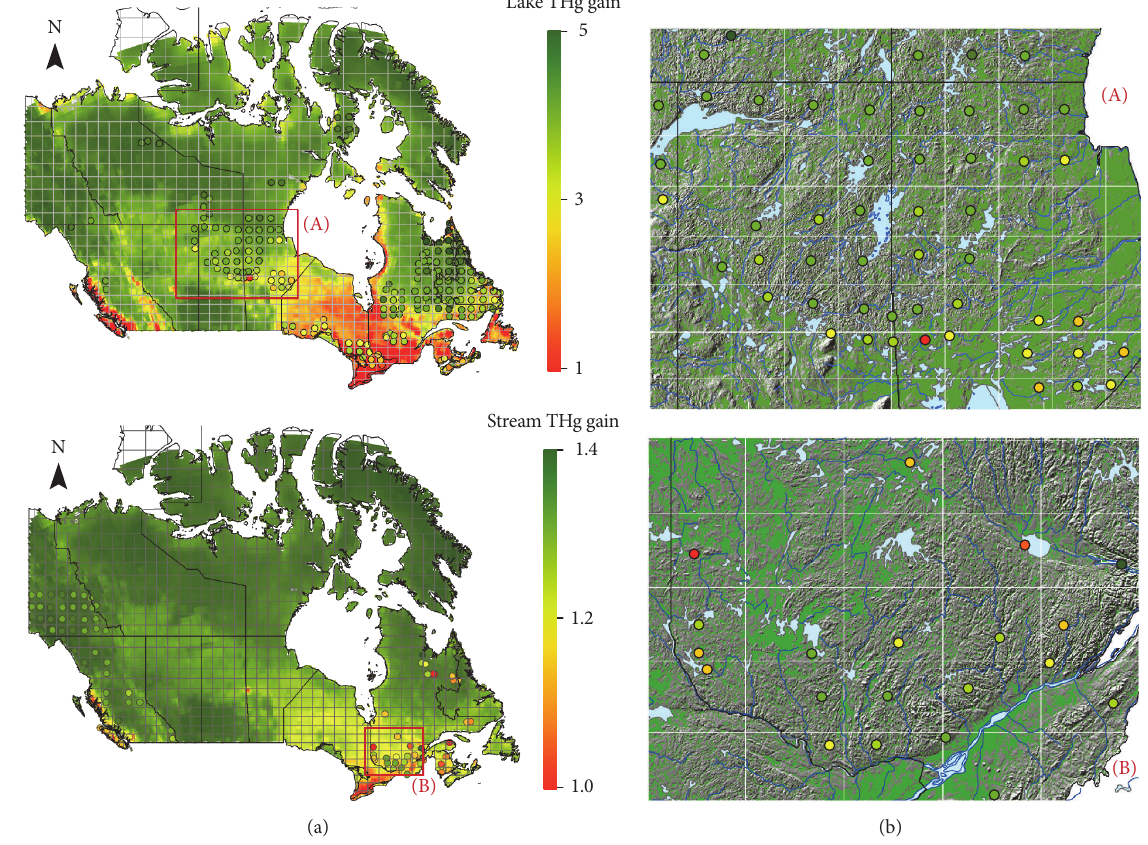
Figure 11: (a) Projected atmospherically derived gains (2) of sediment THg mapped from low (green) to high (red), based on (4), (5), and (6) estimates for LOI (%) and annual net atmospheric Hg deposition as predictor variables. Overlaid dots: the corresponding log 10 THg estimates per NTS tile, using (2), (5), and (6) in combination with the mean GSC-surveyed LOI values. (b) Close-ups for the Hg gains in lake sediments across Manitoba to Alberta (top) and in stream sediments across southwestern Quebec (bottom), overlaid on a hill-shaded digital elevation grid also showing the extent of low-lying and generally wet areas next to lakes and streams (shaded green).